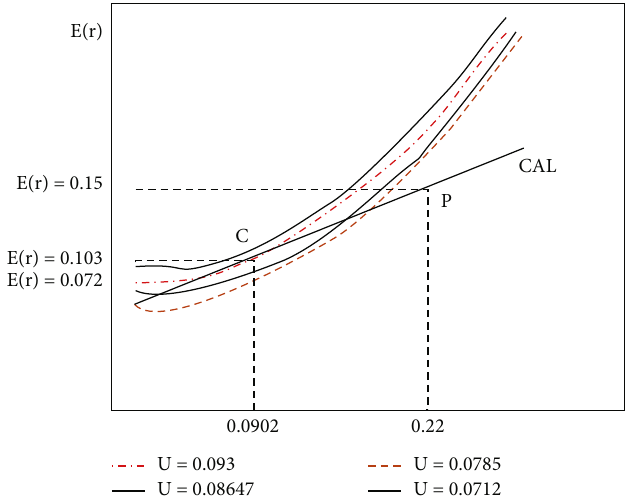
Figure 3: Three cases of key consumer utility